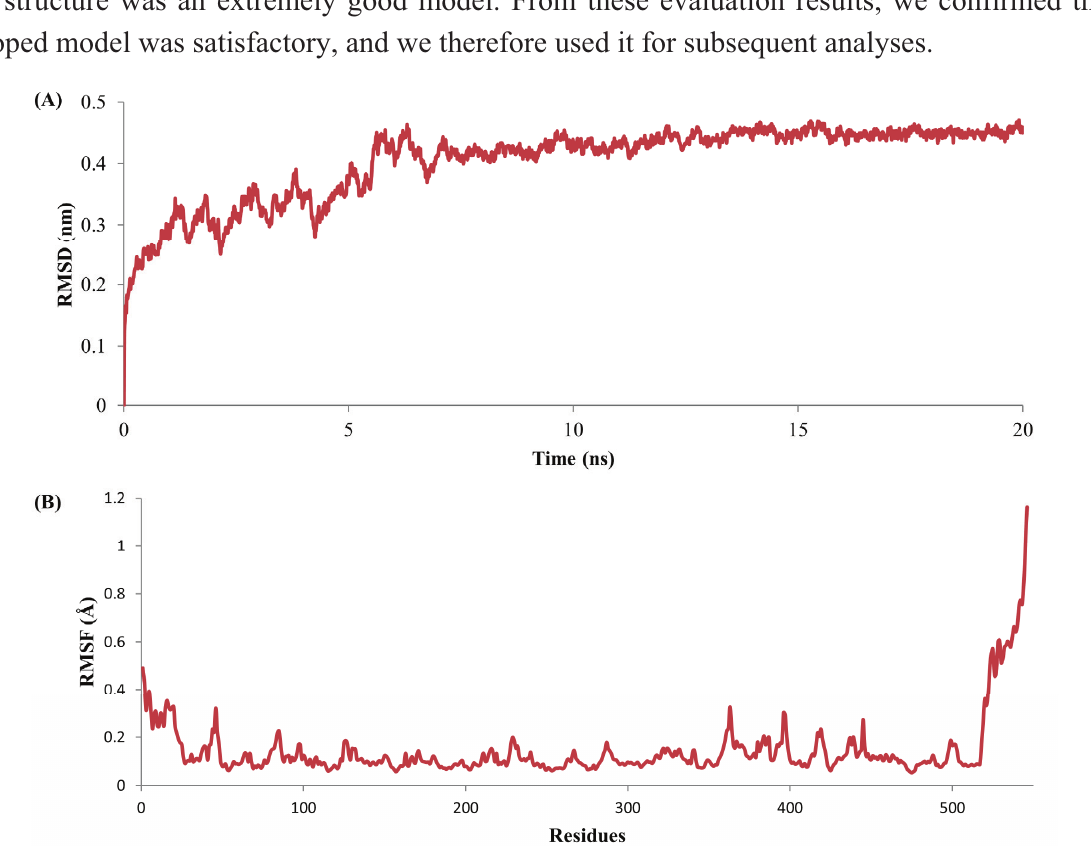
Figure 2. Molecular dynamics based myrosinase model refinement through 20 ns simulation: ( A ) The root mean square deviation (RMSD) values of backbone and ( B ) root mean square fluctuations (RMSF) values of